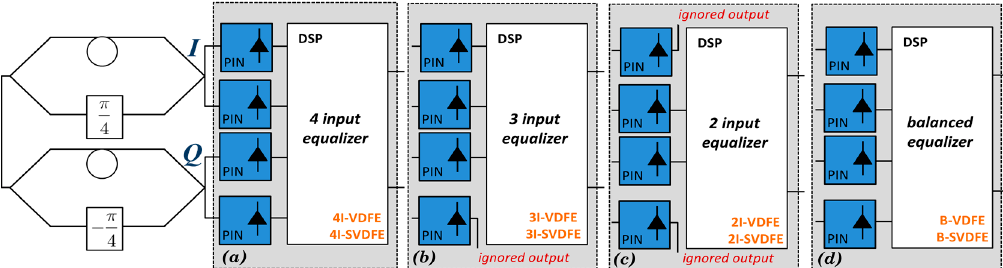
Figure 3. Schematic explanation of different equalizer configurations depending on the receiver type (single-ended or balanced) and number of inputs engaged in the equalization process: ( a ) four-input joint single-ended equalization; ( b ) three-input partially-joint single-ended equalization; ( c ) two-input partially-joint single-ended equalization; and ( d ) balanced equalization.